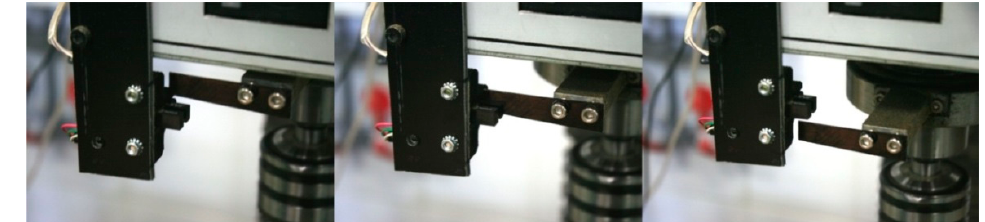
Figure 5. The general view of the cooperation between slotted optical switch with the obstacle mounted on the bench drill spindle housing (from left to right—the situation before, during, and after the interruption of the light beam by the nontransparent obstacle moving down with the spindle housing).